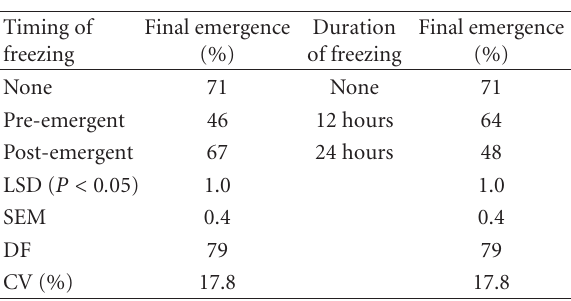
severity has been reported for soil-borne M. nivale infecting ryegrass [18] and oats [9] and Fusarium avenaceum infecting barley from artificial soil inoculation